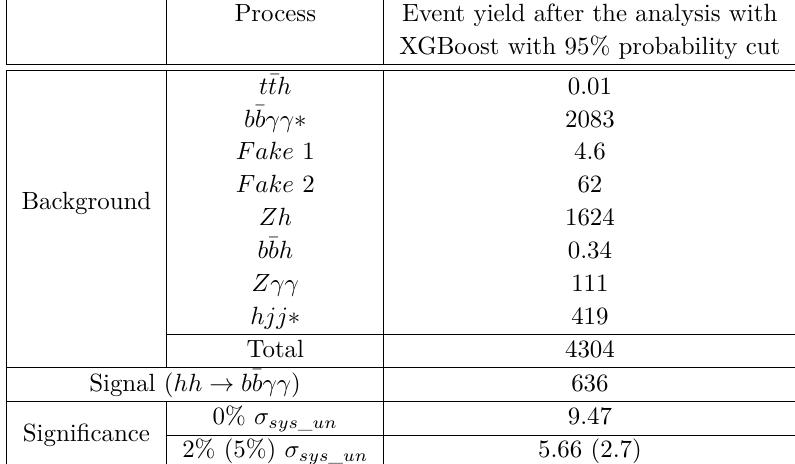
Table 3 . The signal and background yields at the HE-LHC along with the signal significance for the b ¯ bγγ channel upon applying the probability cut on the XGBoost output at 95% .